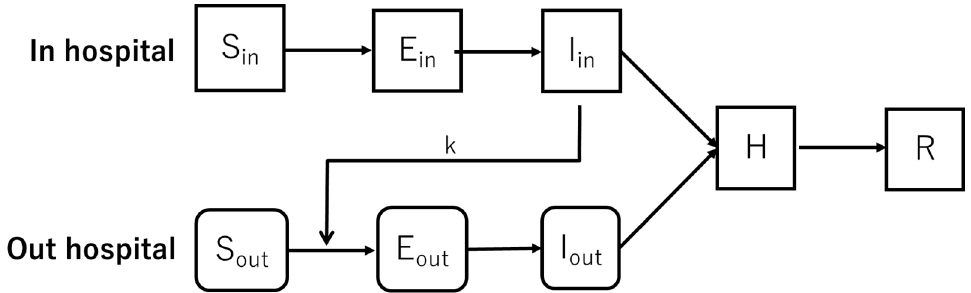
Figure 6. Population transition chart for nosocomial infection model.